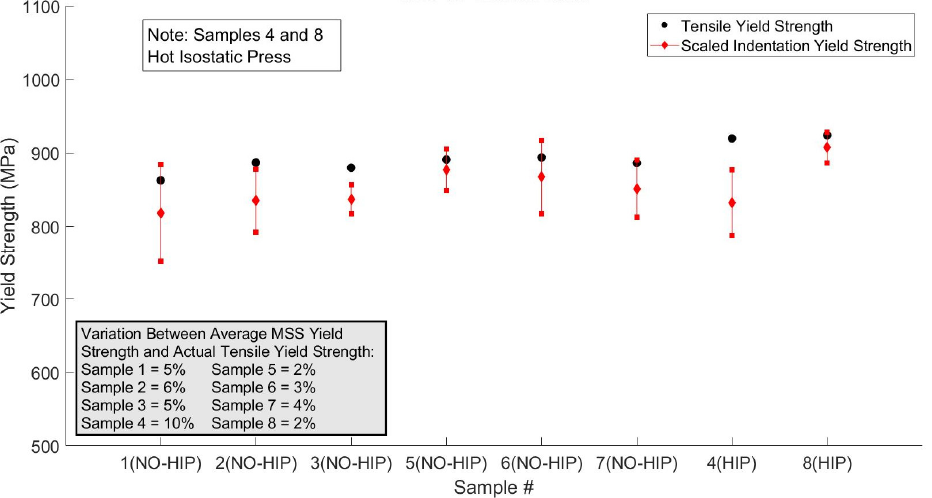
Figure 7. Estimates of yield strengths from MSS tests presented as averages and standard deviations, along with the cor- responding UTT measurements. The table summarizes the percent variation between the average MSS estimated yield strength and the UTT measured yield